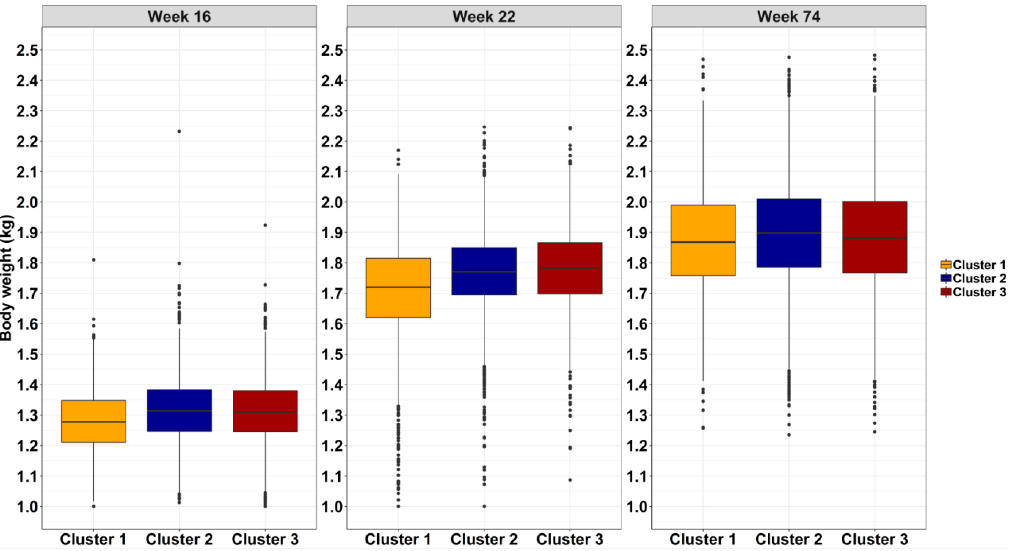
Figure 7. The box plots represent the body weight at 16, 22, and 74 weeks of age for cluster 1 (orange), cluster 2 (dark blue), and cluster 3 (dark red color). The lines on the box plot represent the lower quartile, median, upper quartile, and the interquartile range of body weight of each cluster based on the K-means solution.